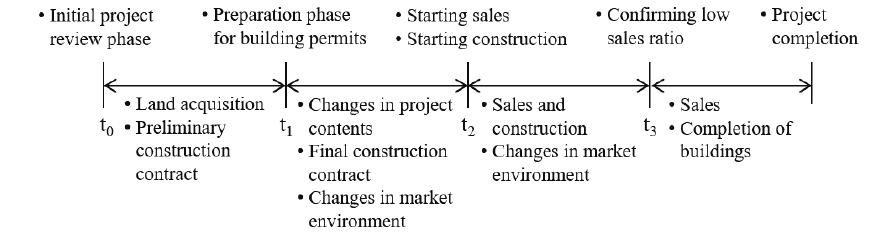
Figure 5. Simulation phases of economic